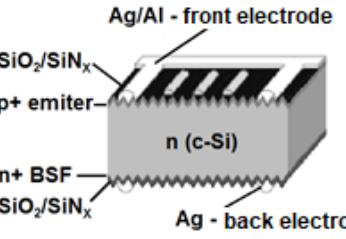
Figure 1. Diagram of: ( a ) bifacial, ( b ) monofacial module [1]. Due to additional absorption of the radiation incident on the rear side of the cell and the increased number of photocarriers generated, a bifacial module generates greater cur- rent and voltage than that of the monofacial module, making it possible to obtain more power. The additional energy yield depends on the amount of intense solar radiation re- flected from the ground and reaching the module’s rear side. One of the most common bifacial cells structures is the p + - p - n + structure, based on an n-type semiconductor (shown in Figure 2). Silicon oxide or nitride (SiO 2 /SiNx) are used for front side and rear side pas- sivation. The front side mesh is composed of silver or aluminum (Ag/Al), and the rear side mesh is composed of silver (Ag). Figure 2. The diagram of a type of bifacial cell p + -n-n + [2].